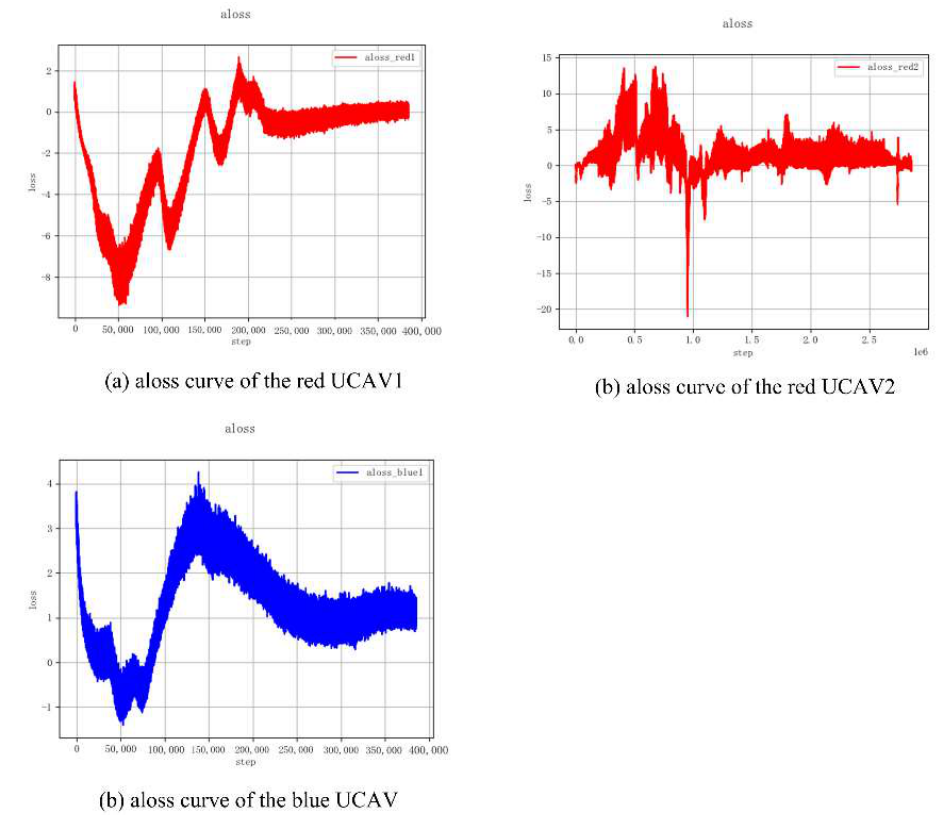
Figure 6. Loss curve.